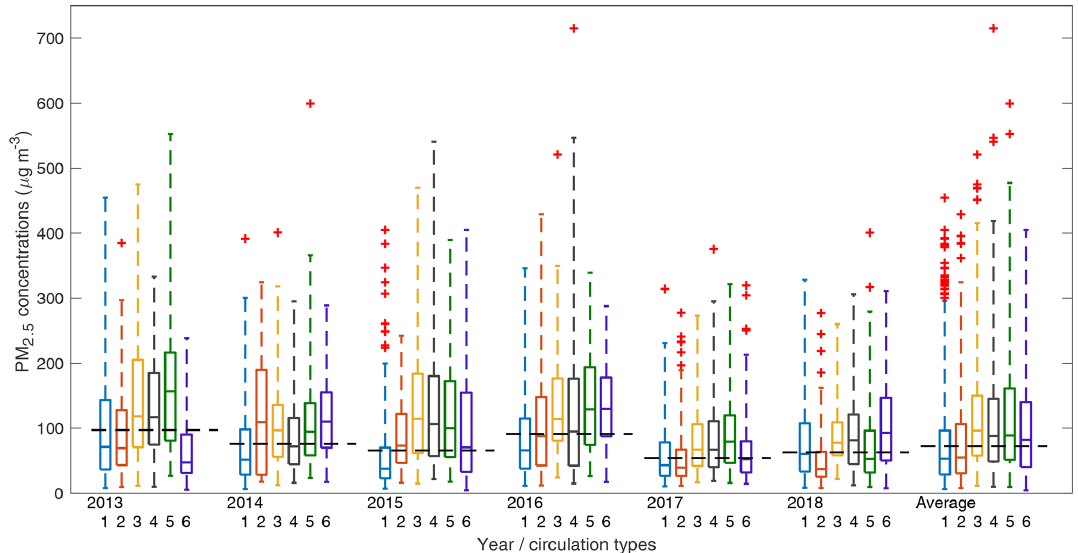
Figure 7. The box plot of the PM 2 . 5 concentrations varies with the circulation types. To exclude the effect of emission reduction on the annual mean PM 2 . 5 concentrations, the PM 2 . 5 distributions at the year and multiyear (average) scales are shown here. The dashed line for each year indicates the median PM 2 . 5 concentrations in wintertime of a specific year.